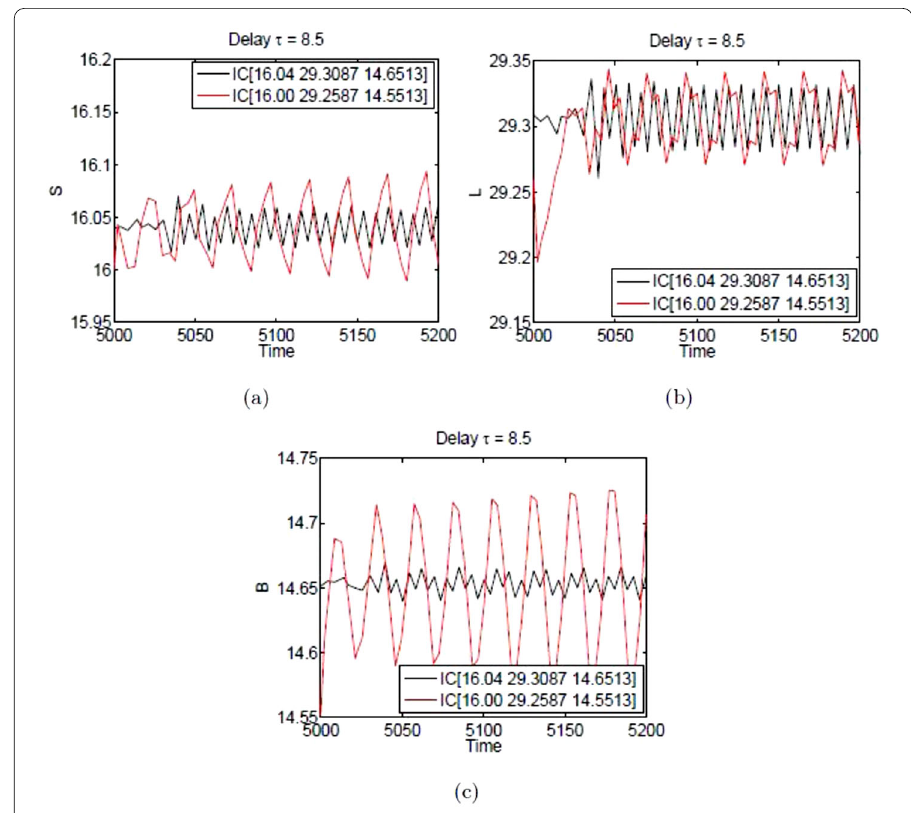
Figure 7 Time series and SIC test of ( a ) uninfected/susceptible node, ( b ) latent node, and ( c ) breaking-out node at τ = 8.5. The values of other parameters are as in